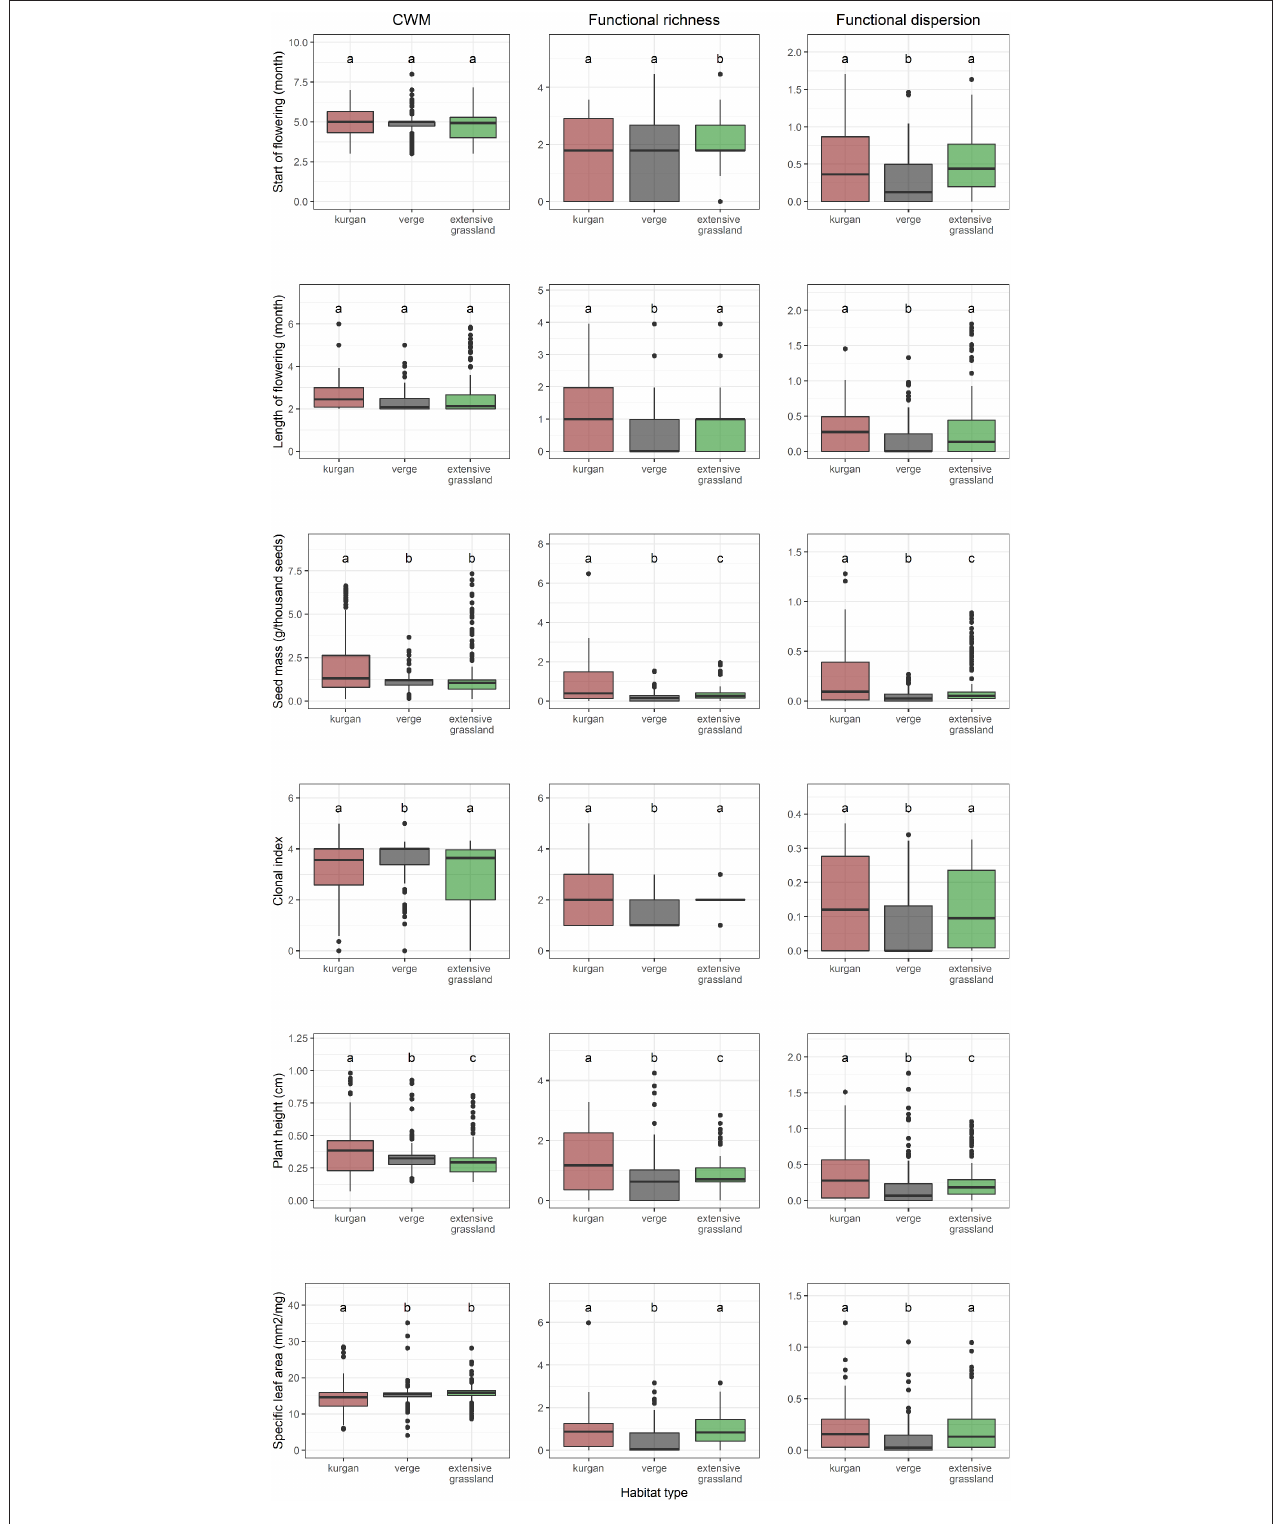
FIGURE 3 | Distributions of community weighted mean (CWM), functional richness (FRic), and dispersion (FDis) of single traits of specialists in the three studied habitat types (kurgans, verges, and extensive grasslands). Boxes, vertical whiskers, bold horizontal lines, and individual dots represent interquartile range (IQR: value range between 25 and 75% quartiles), minimum and maximum value range (excluding outliers), median, and outliers (values being at least 1.5 times the IQR lower than the lower quartile, or 1.5 times IQR higher than the upper quartile), respectively. Different letters denote significant differences between groups (GLMM; p ≤ 0.05 after Tukey’s